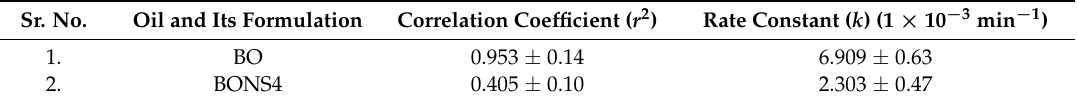
Table 6. Correlation coefficient ( r 2 ) and rate constant ( k ) of BO and BONS4 photo degradation under UVA